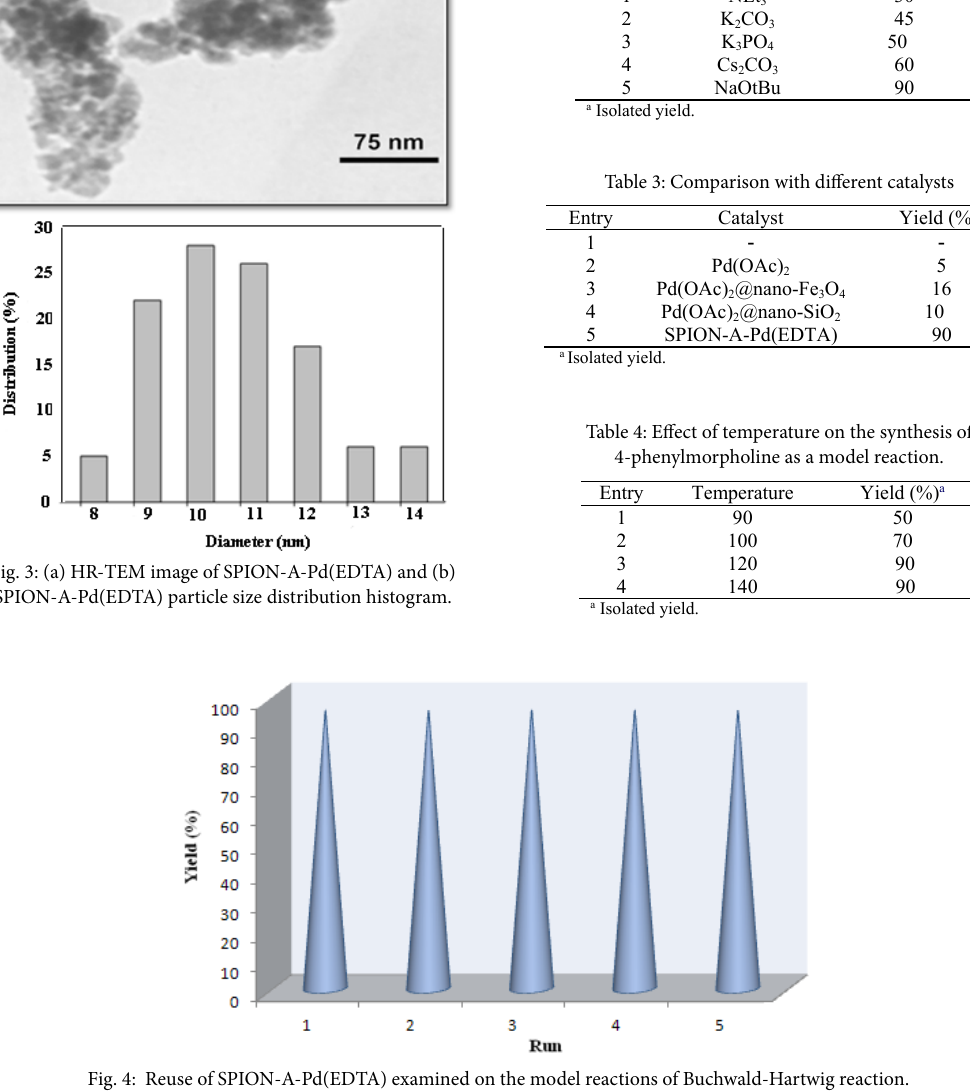
233 Nanochem Res 2(2): 230-236, Summer and Autumn 2017